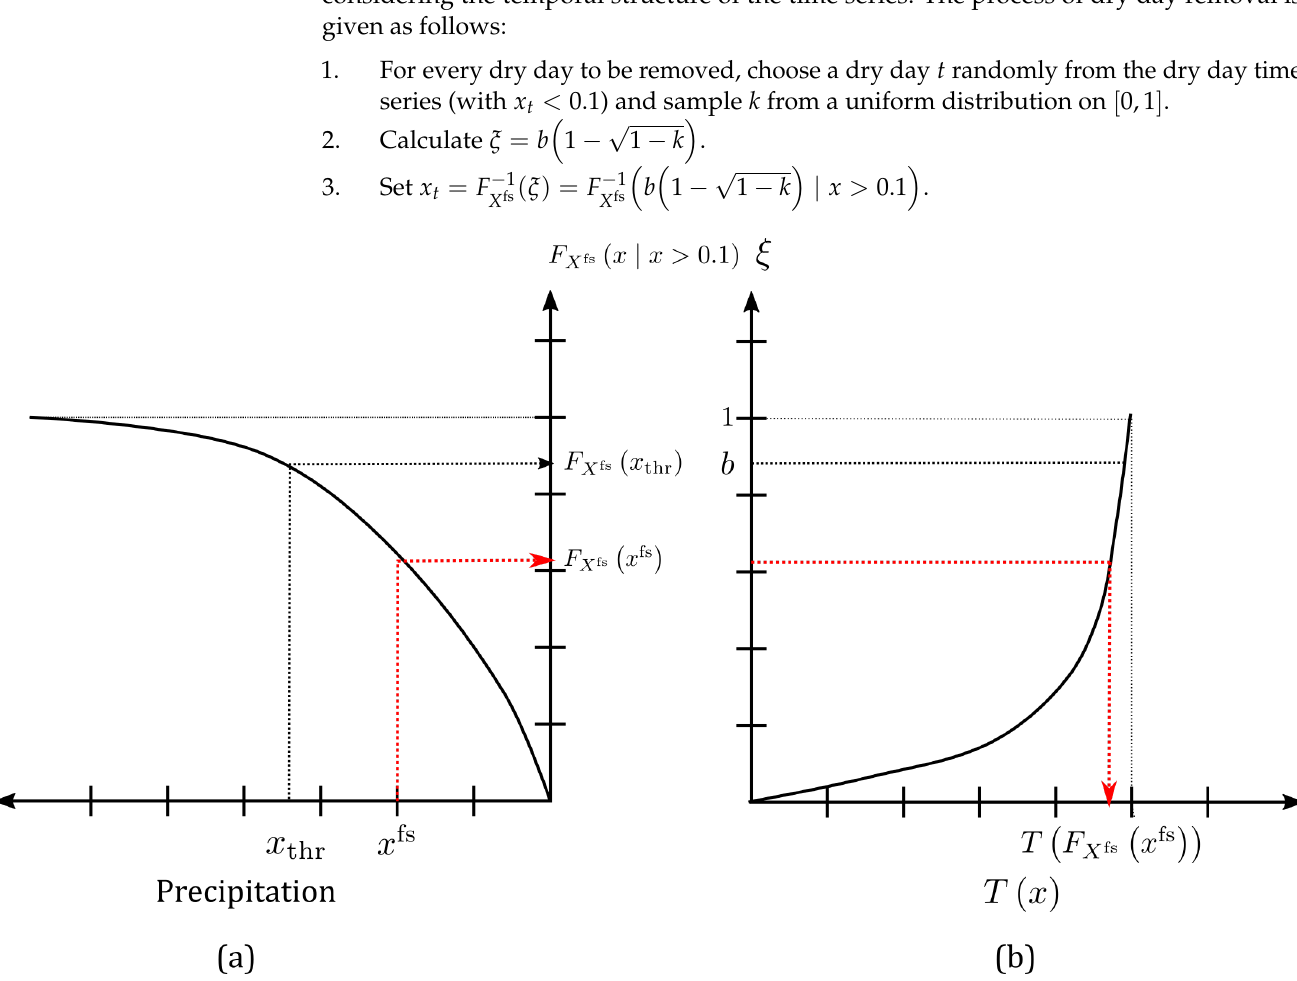
Figure 2. Overview of the distributions used in TDA: ( a ) CDF of the precipitation of the wet days in the future simulation, ( b ) CDF of the triangular distribution. The red arrow displays how a value x fs is transformed into a value T ( ξ ) in the wet-to-dry case. The black arrow indicates the threshold value. Adapted from Pham [37].